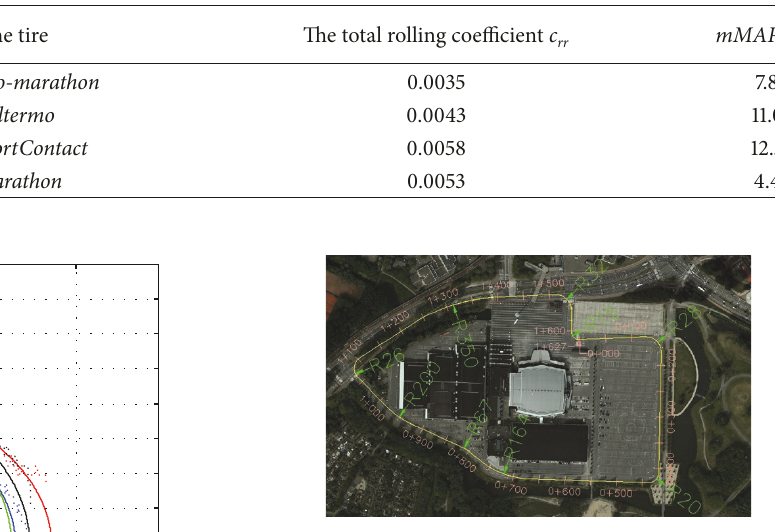
Figure 13: Plan view of the path of the drive on route 1 in